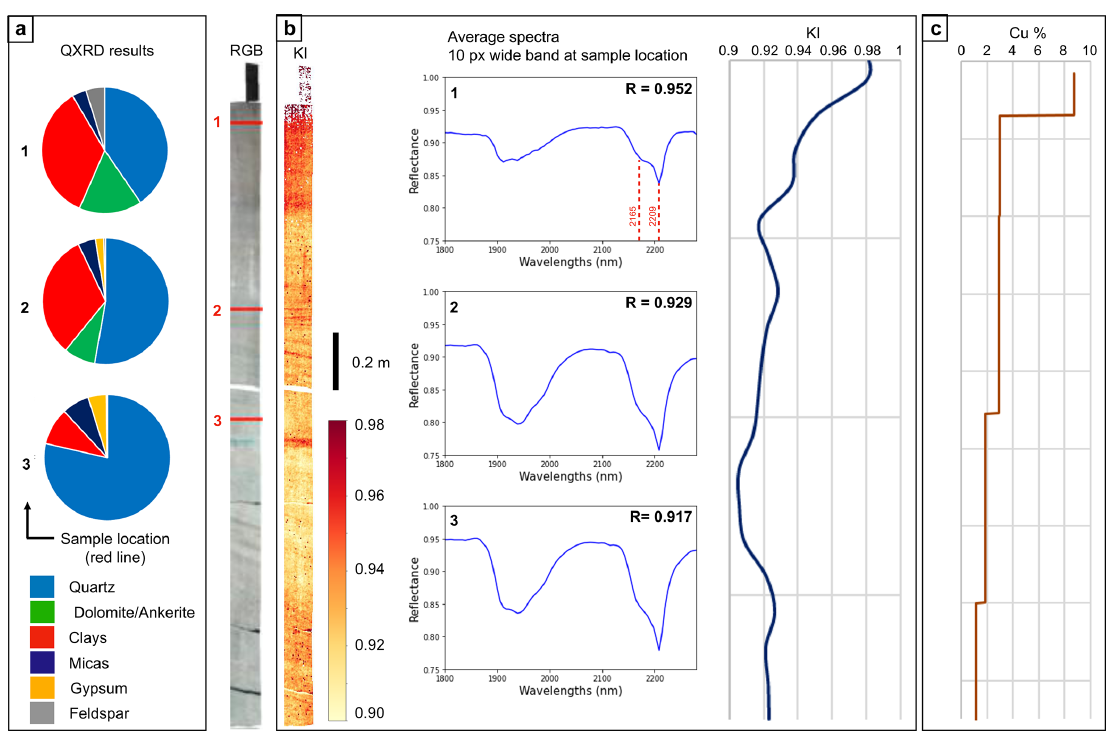
Figure 11. (a) QXRD results (Kehrer, 2016) for three samples at various depths in drill core 131 (1, 2, and 3); (b) KI map of sandstones and organic-rich shales; average spectra in a 10-pixels-wide band ( ≈ 1cm) at QXRD samples location; KI average along the core, and (c) the copper grade.